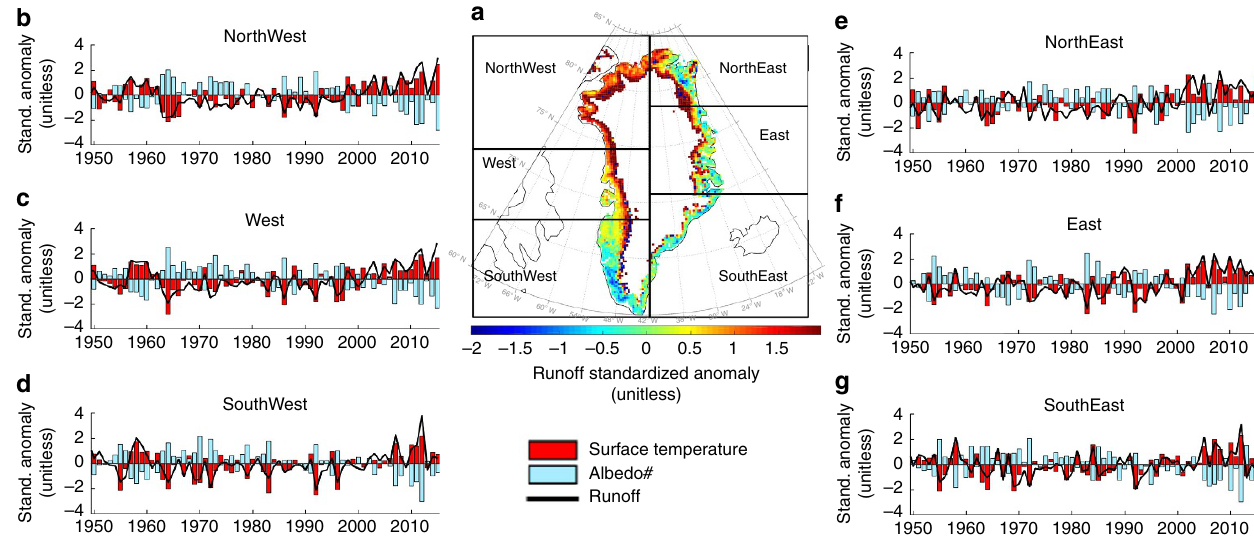
Figure 3 | Surface mass balance and energy balance quantities over the Greenland ice sheet. ( a ) Spatial distribution of the July 2015 MAR-simulated runoff anomaly (unitless) over the Greenland ice sheet (1981–2010). The boxes in the map display the boundaries of the different drainage regions. ( b – g ) Time series of standardized anomalies (unitless) for mean July runoff (black line), surface temperature (red bars) and surface broadband albedo (cyan bars) for the period 1950–2015 over the different drainage basin regions identified in a , as simulated by the MAR